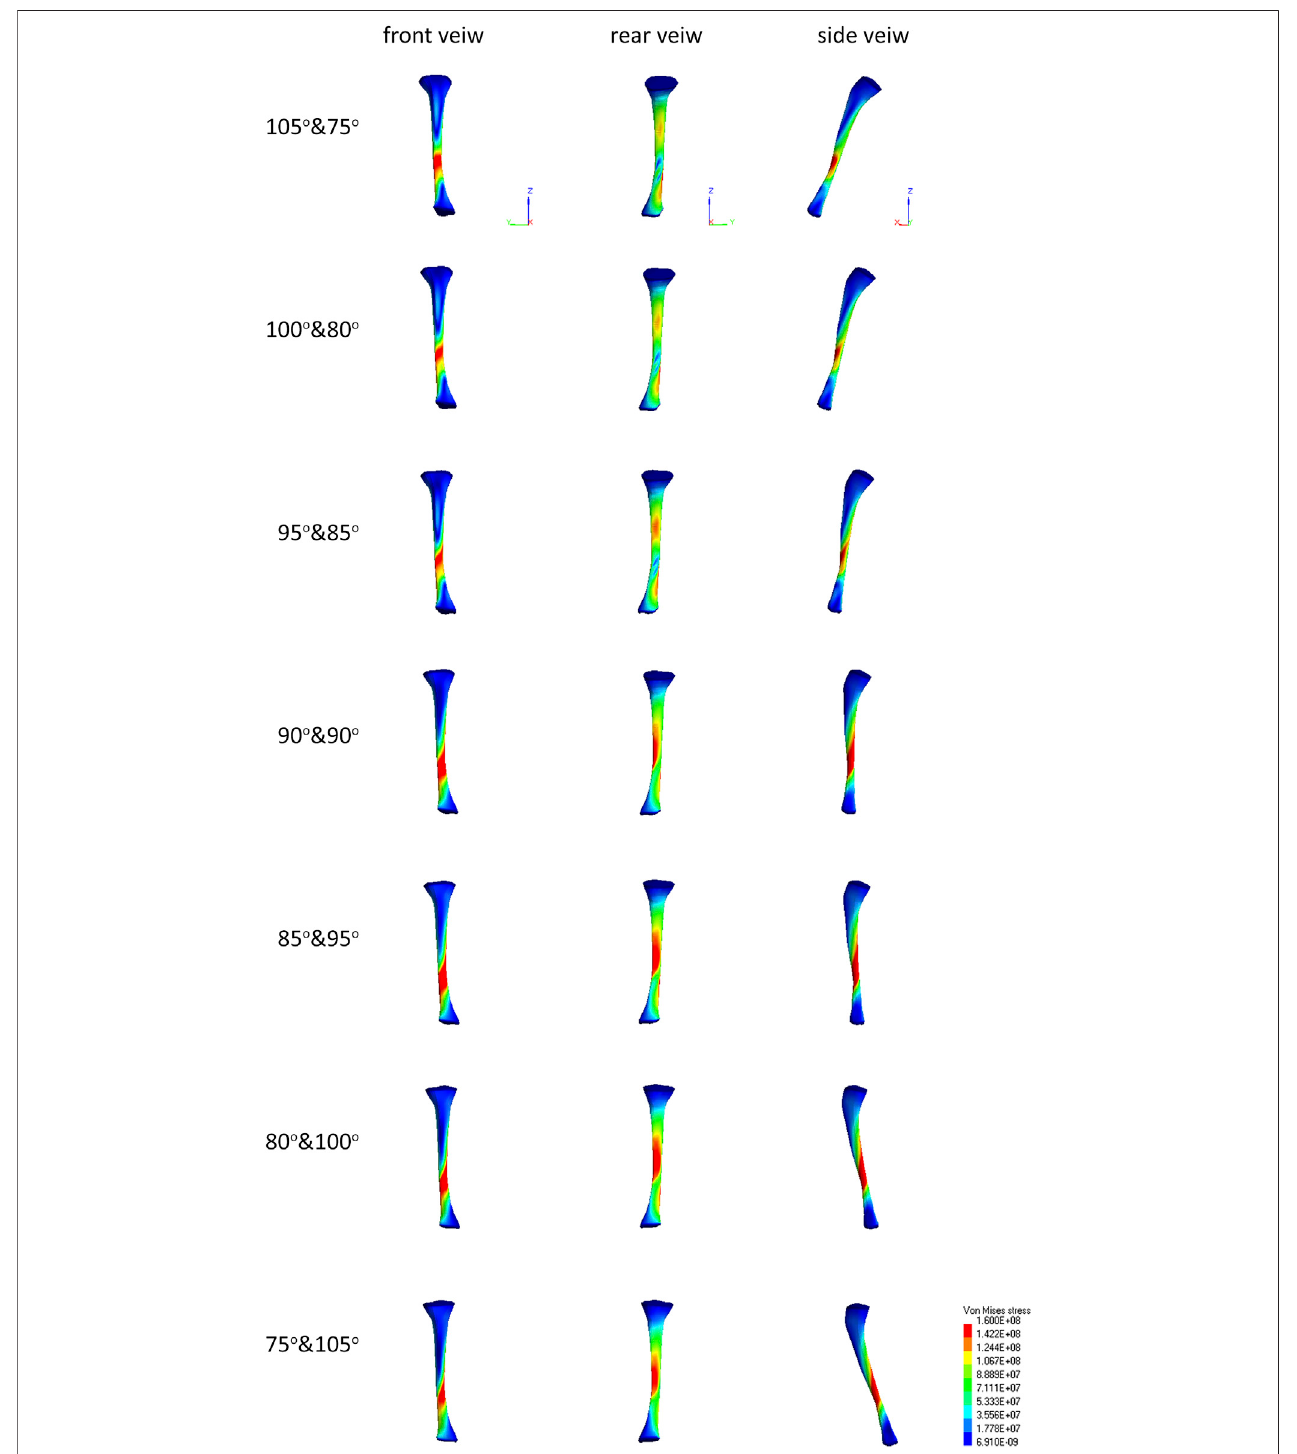
FIGURE 6 | Stress fi eld maps of tibia for different positions.